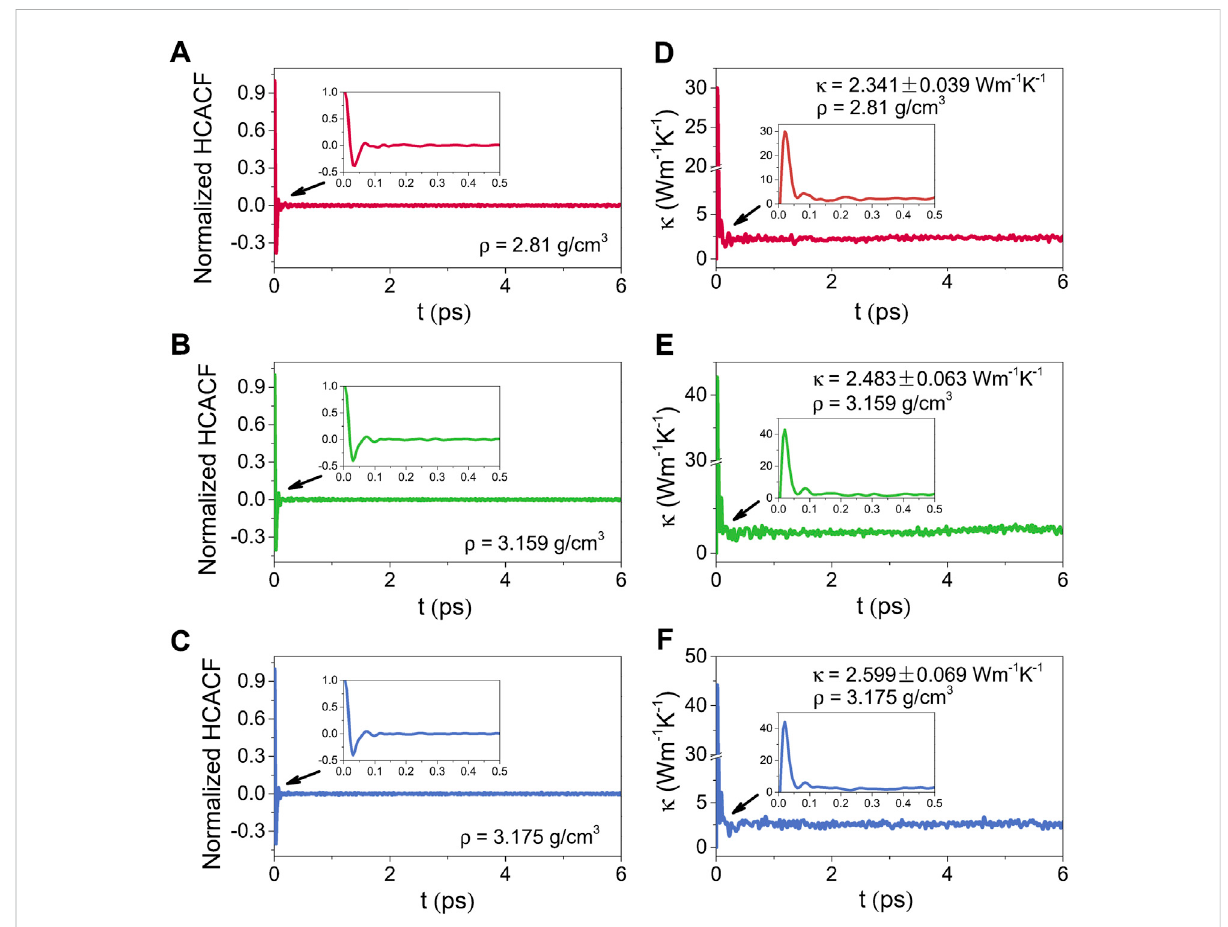
FIGURE 10 NormalizedHCACFs for (A) ρ =2.81 g/cm 3 , (B) ρ = 3.159 g/cm 3 and (C) ρ = 3.175 g/cm 3 , and thermal conductivities( κ )for (D) ρ =2.81 g/cm 3 , (E) ρ = 3.159 g/cm 3 and (F) ρ = 3.175 g/cm 3 as a function of the correlation time for amorphous alumina at 300 K, insets: the normalized HCACFs and thermal conductivities over the correlation time of 0 – 0.5